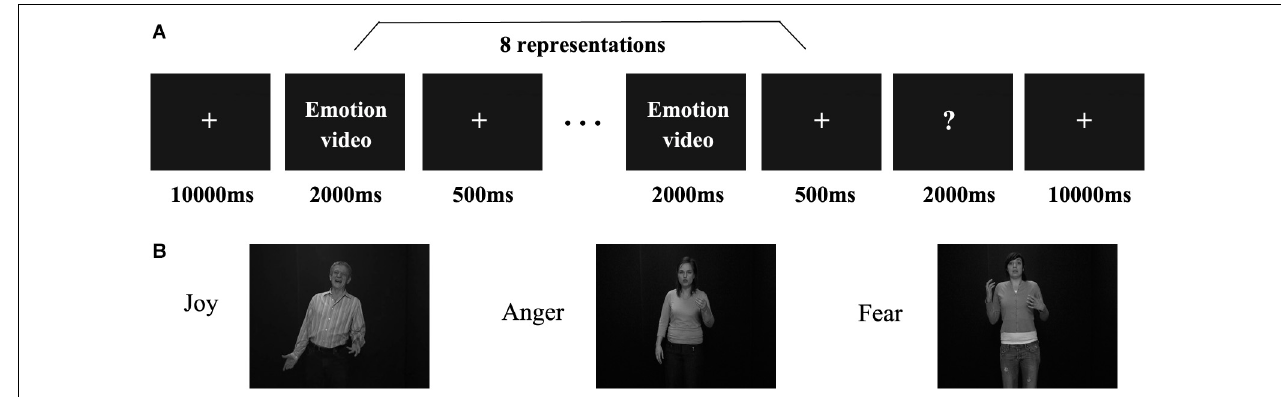
FIGURE 1 | Paradigm representation of the main experiment and example emotional stimuli. (A) Schematic representation of the paradigm used. A cross was presented for 10 s before each block, after which eight emotional stimuli appeared. Subsequently, participants completed a button task to indicate their identification of the emotion category they had seen in the previous block. (B) All emotional stimuli were taken from the geneva multimodal emotion portrayals (GEMEP) database. Videos of whole individuals displaying three emotions (joy, anger, and fear) were used in the experiment.